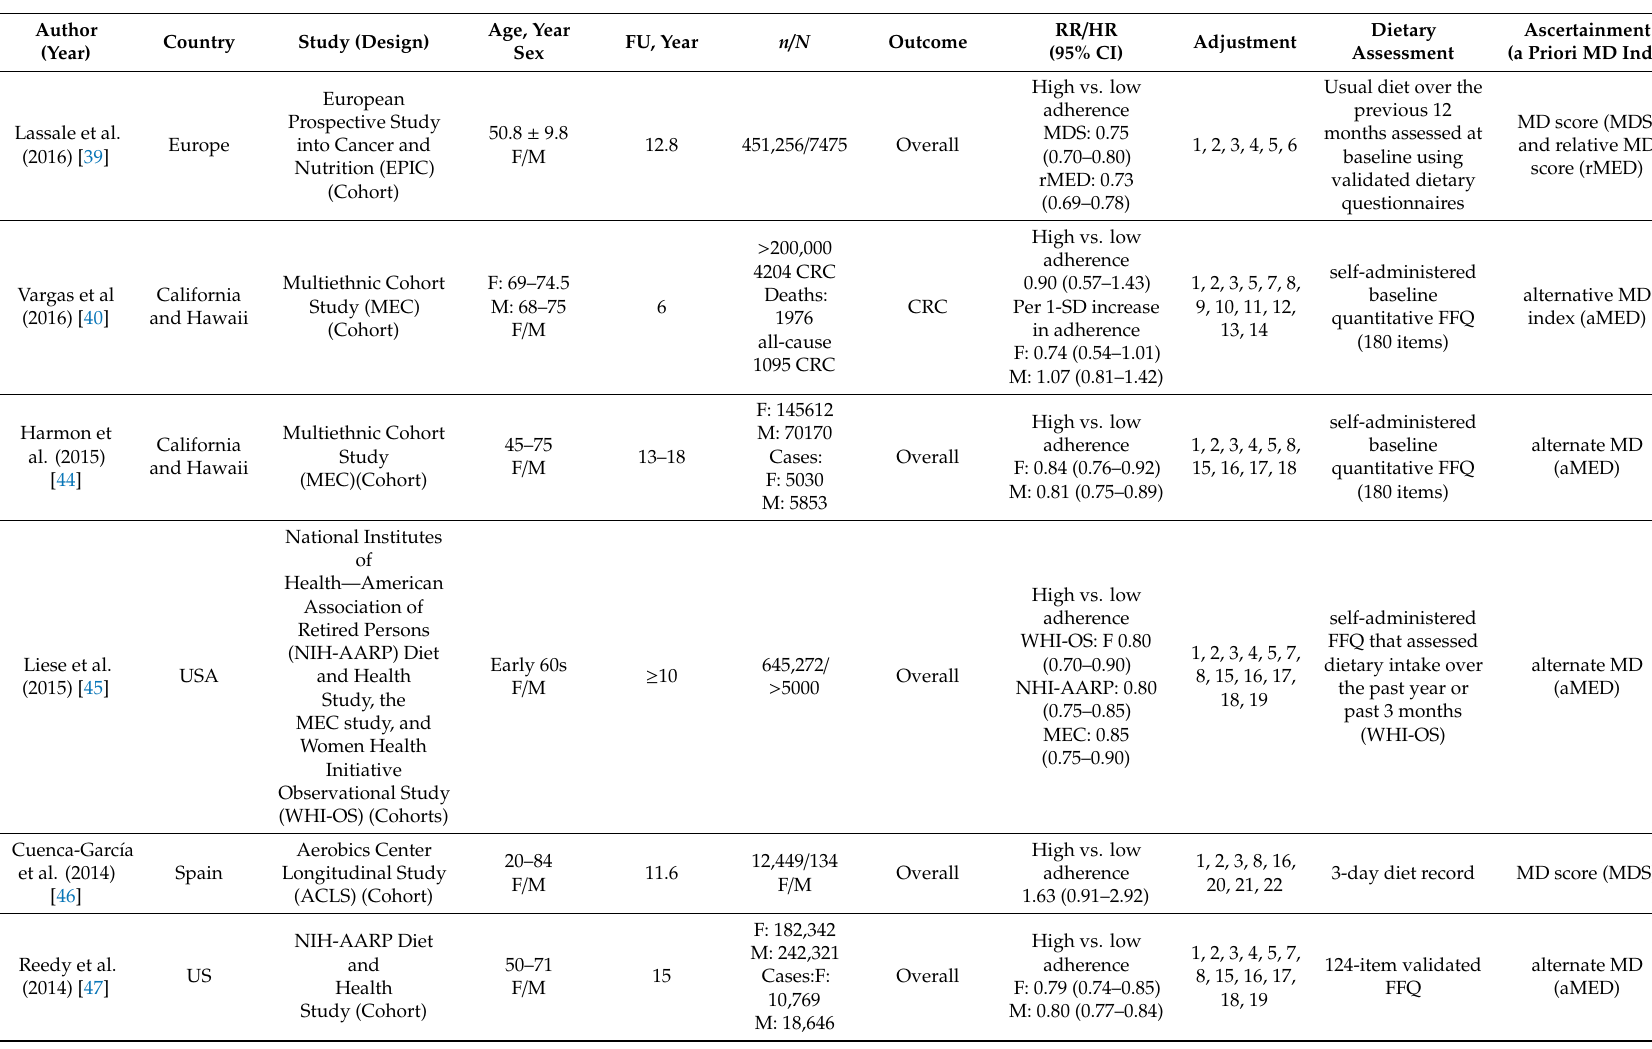
Table 3. Characteristics of the studies evaluating the Mediterranean diet (high vs. low adherence) and cancer mortality including cause-specific cancer